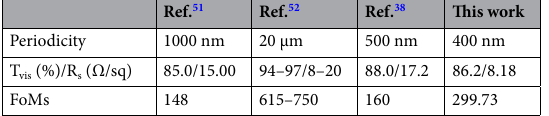
Table 5. Comparison among our proposed NPWs and other